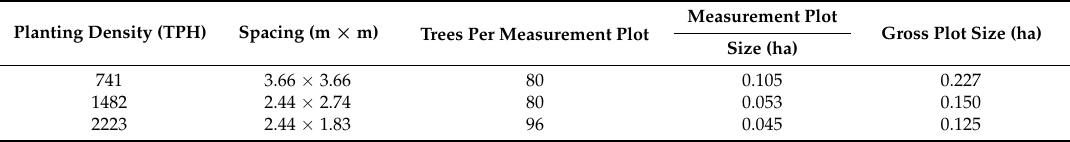
Table 3. Planting density plot sizes for the PMRC SAGS Culture × Density